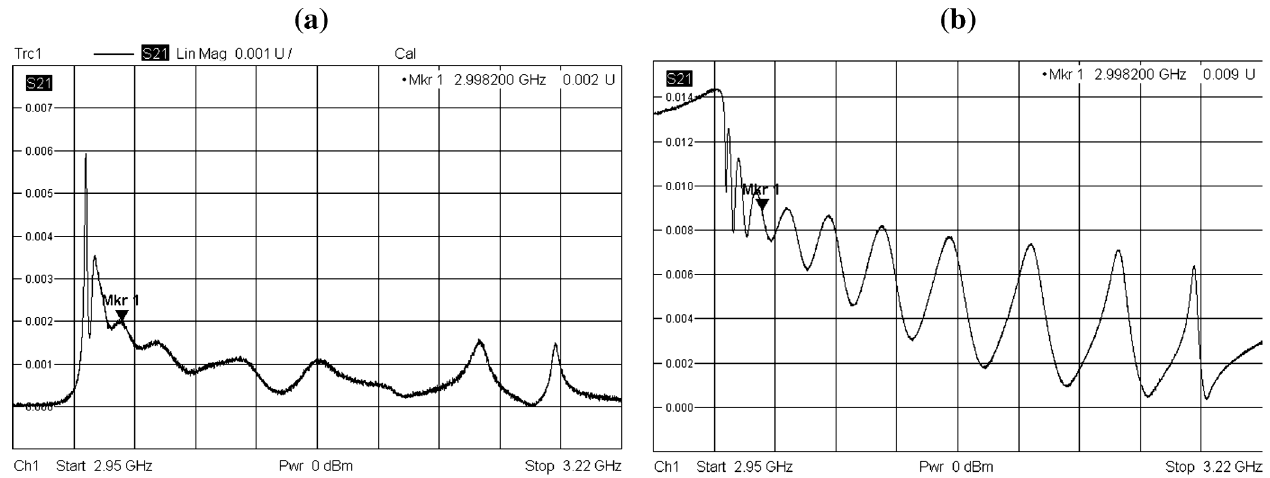
FIG. 19. Transmission coefficient between the input coupler and the antennas on the fifth (a) and first (b) TW cell.